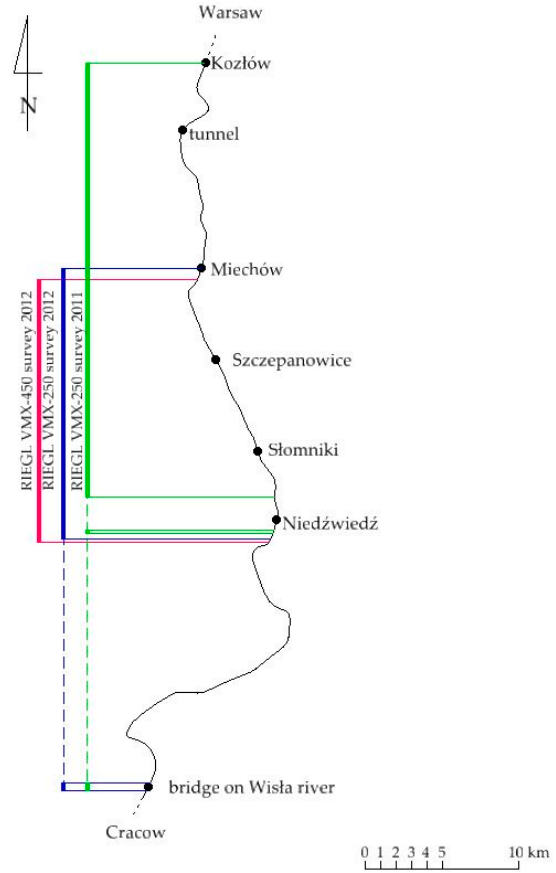
Figure 12. Ranges of individual test routes.